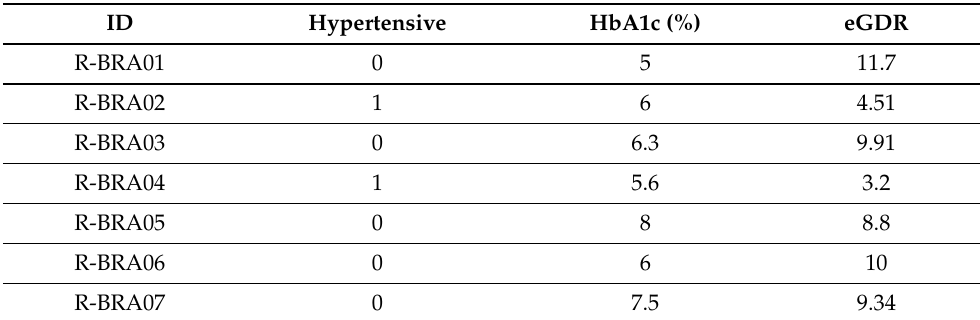
Table 5. Information used to calculate estimated glucose disposal rate